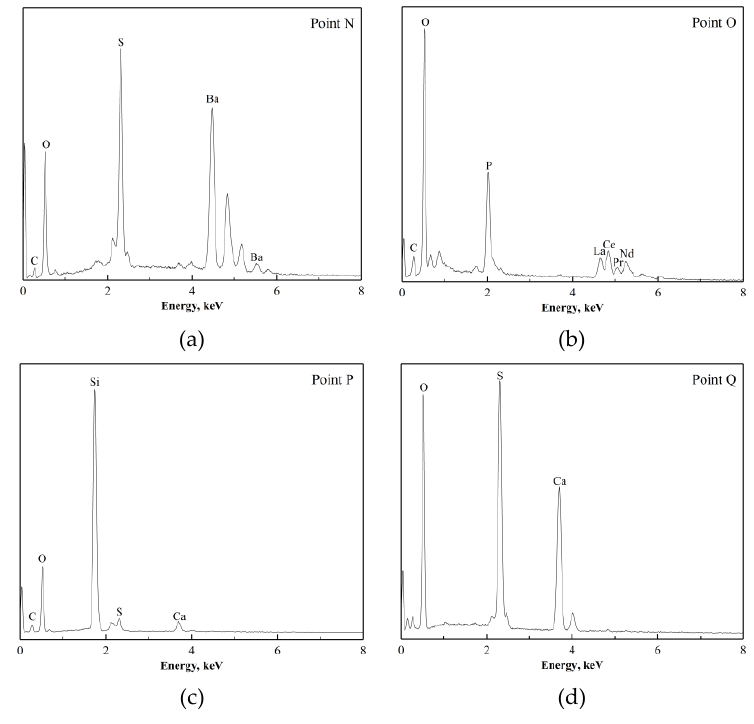
Figure 21. EDS spectra of the leaching residues: ( a ) BaSO 4 ; ( b ) REPO 4 ; ( c ) SiO 2 ; ( d ) CaSO 4 .